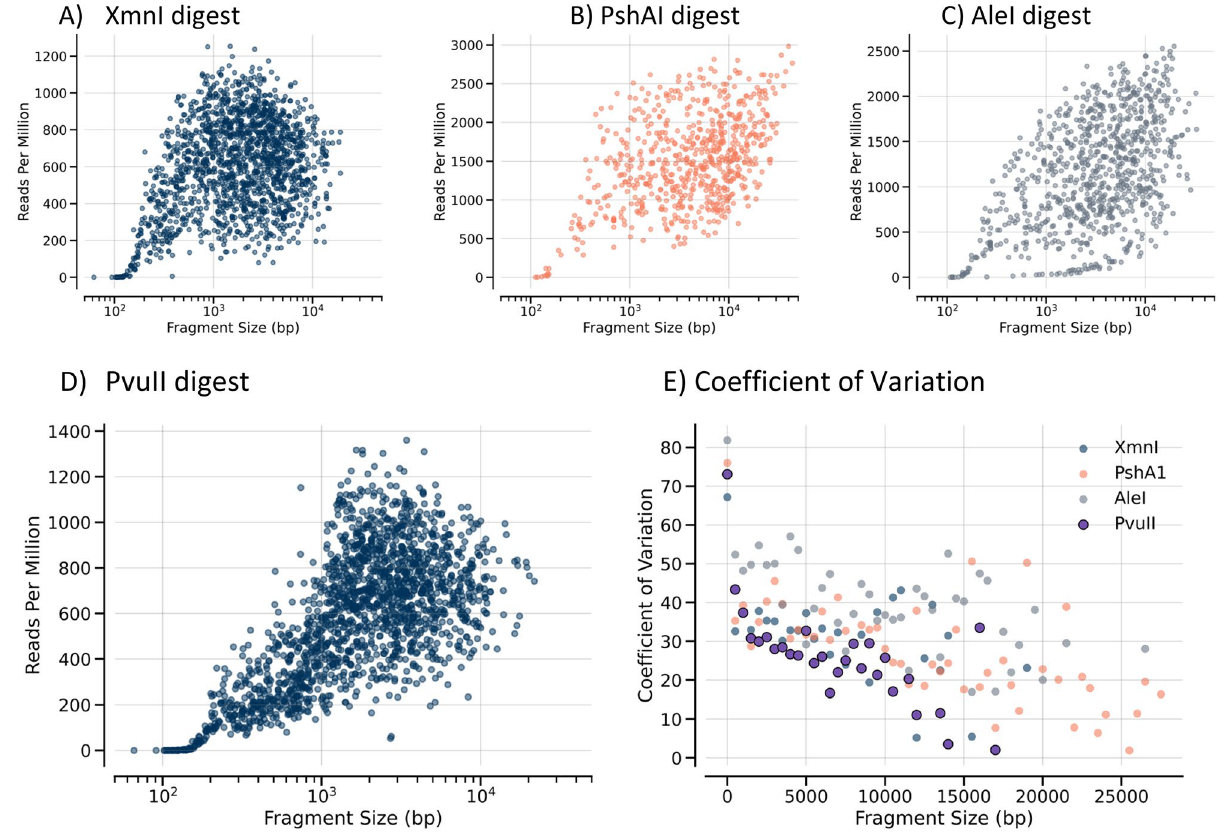
Figure 7. Read frequency versus length with Oxford Nanopore ligation-based library preparation. The normalized frequencies of all DNAs cut with XmnI ( A ), PshI ( B ), AleI ( C ), and PvuII ( D ) are shown as a function of length when the DNA is prepared using the ligation-based method for Oxford Nanopore. The coefficient of variation ( E ) for frequency for each digest as a function of length using 500 bp bins is also shown for each digest with the PvuII digest shown with larger symbols to distinguish more easily from the digests with variable end sequences.